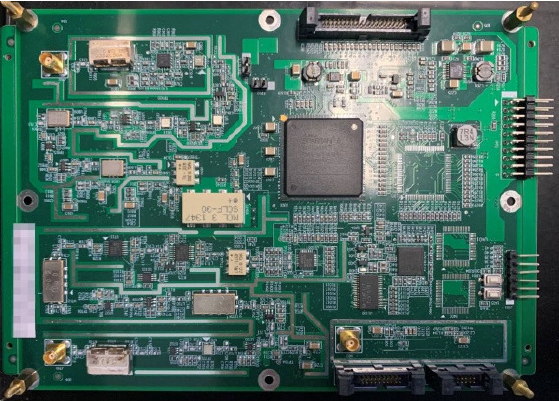
7 of 24 Figure 4. Node-to-node asymmetric double-sided two-way ranging measurement process. The inter-satellite range measurement equation is 2